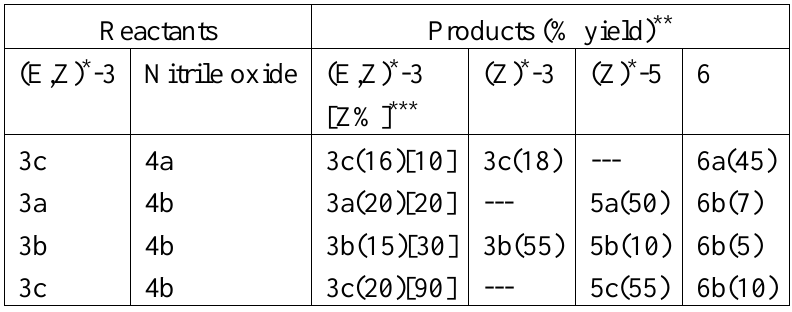
Table 1: Reactions of E,Z-3a-c with Nitrile Oxides 4a and 4b